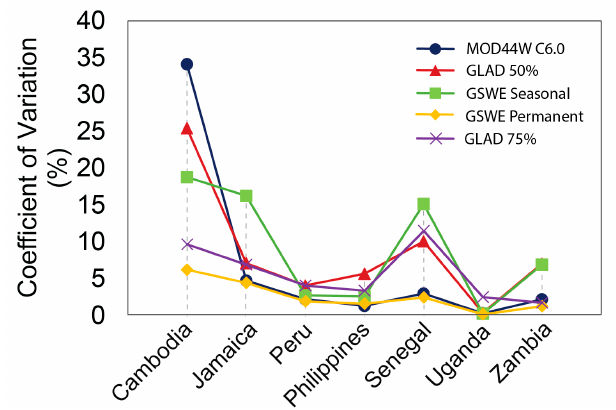
Figure 5. Coefficient of variation for five of the six datasets (sixth not shown for brevity), calculated for each country as the ratio of the standard deviation to the mean for the entire study period of 2000 to 2015. Remote Sens. 2020 , 12 , 1634